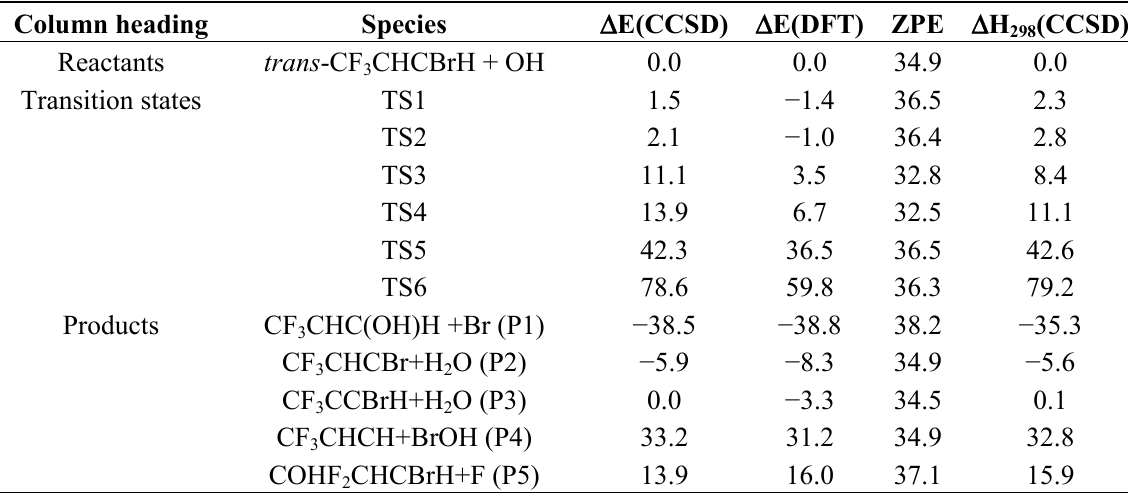
Table 1. The relative energies (in kcal/mol), Δ E (DFT), Δ E (CCSD) and Δ H well as the zero-point vibration energies (ZPVEs) of species involved in the BTP reaction with OH.